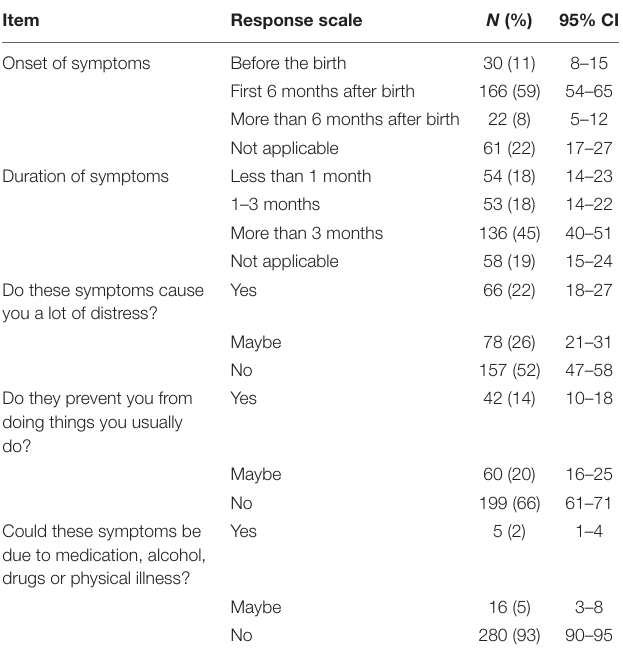
TABLE 4 | Onset and impact of PTSD in Fathers/Birth